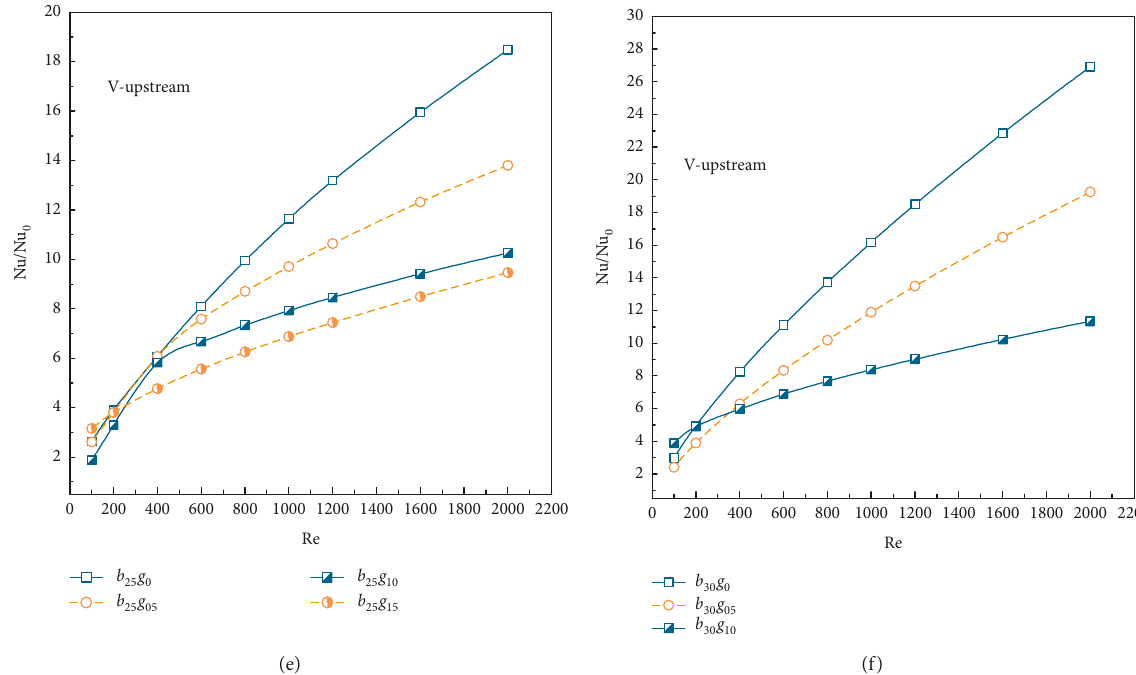
Figure 12: Relation of Nu/Nu 0 with the Reynolds number for (a) b05, (b) b10, (c) b15, (d) b20, (e) b25, and (f) b30 at V-upstream arrangement.